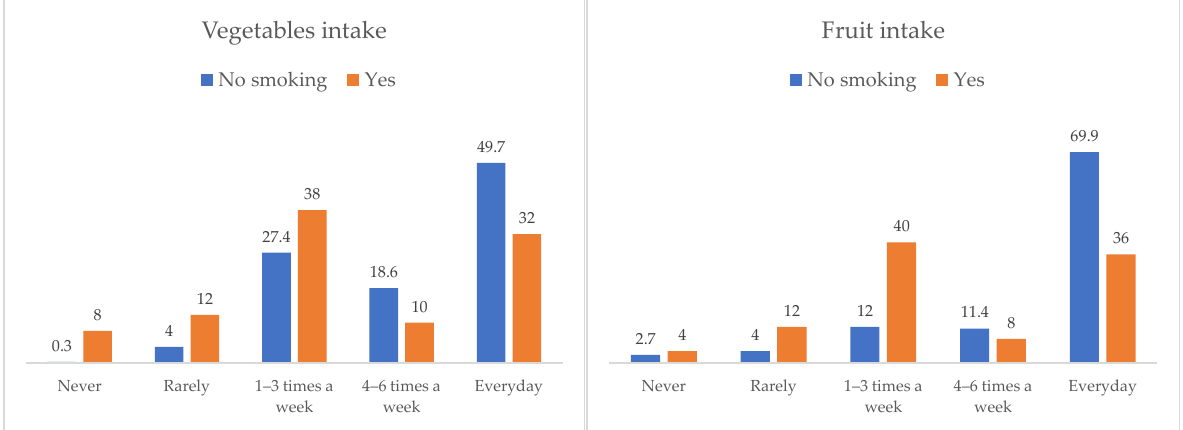
Figure 2. Frequency of vegetable and fruit intake by smoking